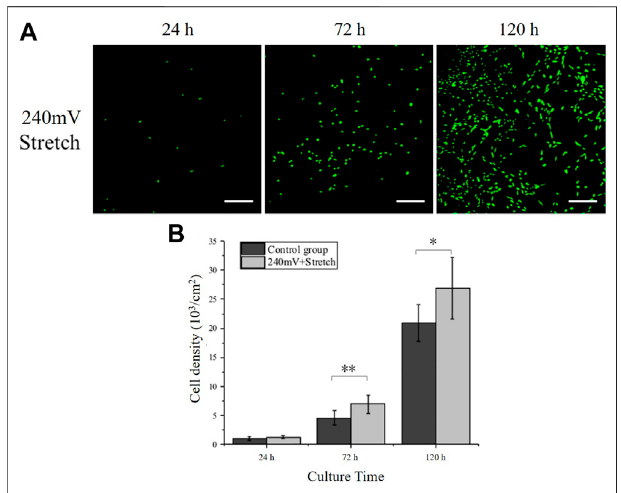
FIGURE 5 | PC12 cell proliferation under electromechanical stimulation. (A) Immuno fl uorescence images of PC12 cells cultured under electromechanical stimulation. electrical stimulation: 240 mV, 20 Hz; Stretch: 10%, 0.25 Hz. Scale bar: 100 μ m. (B) Cell densities measurement. The signi fi cant difference between groups is indicated ( p , p < 0.05; pp , p < 0.01; n > 10